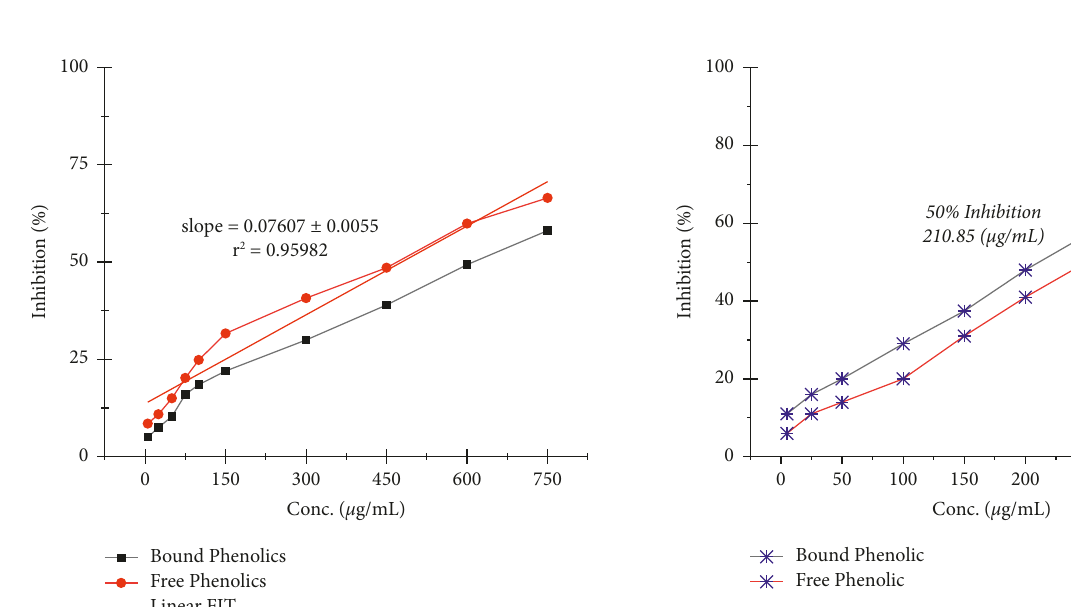
Figure 4: α -Amylase median inhibitory potential of Schoenoplectus triqueter phenolics.